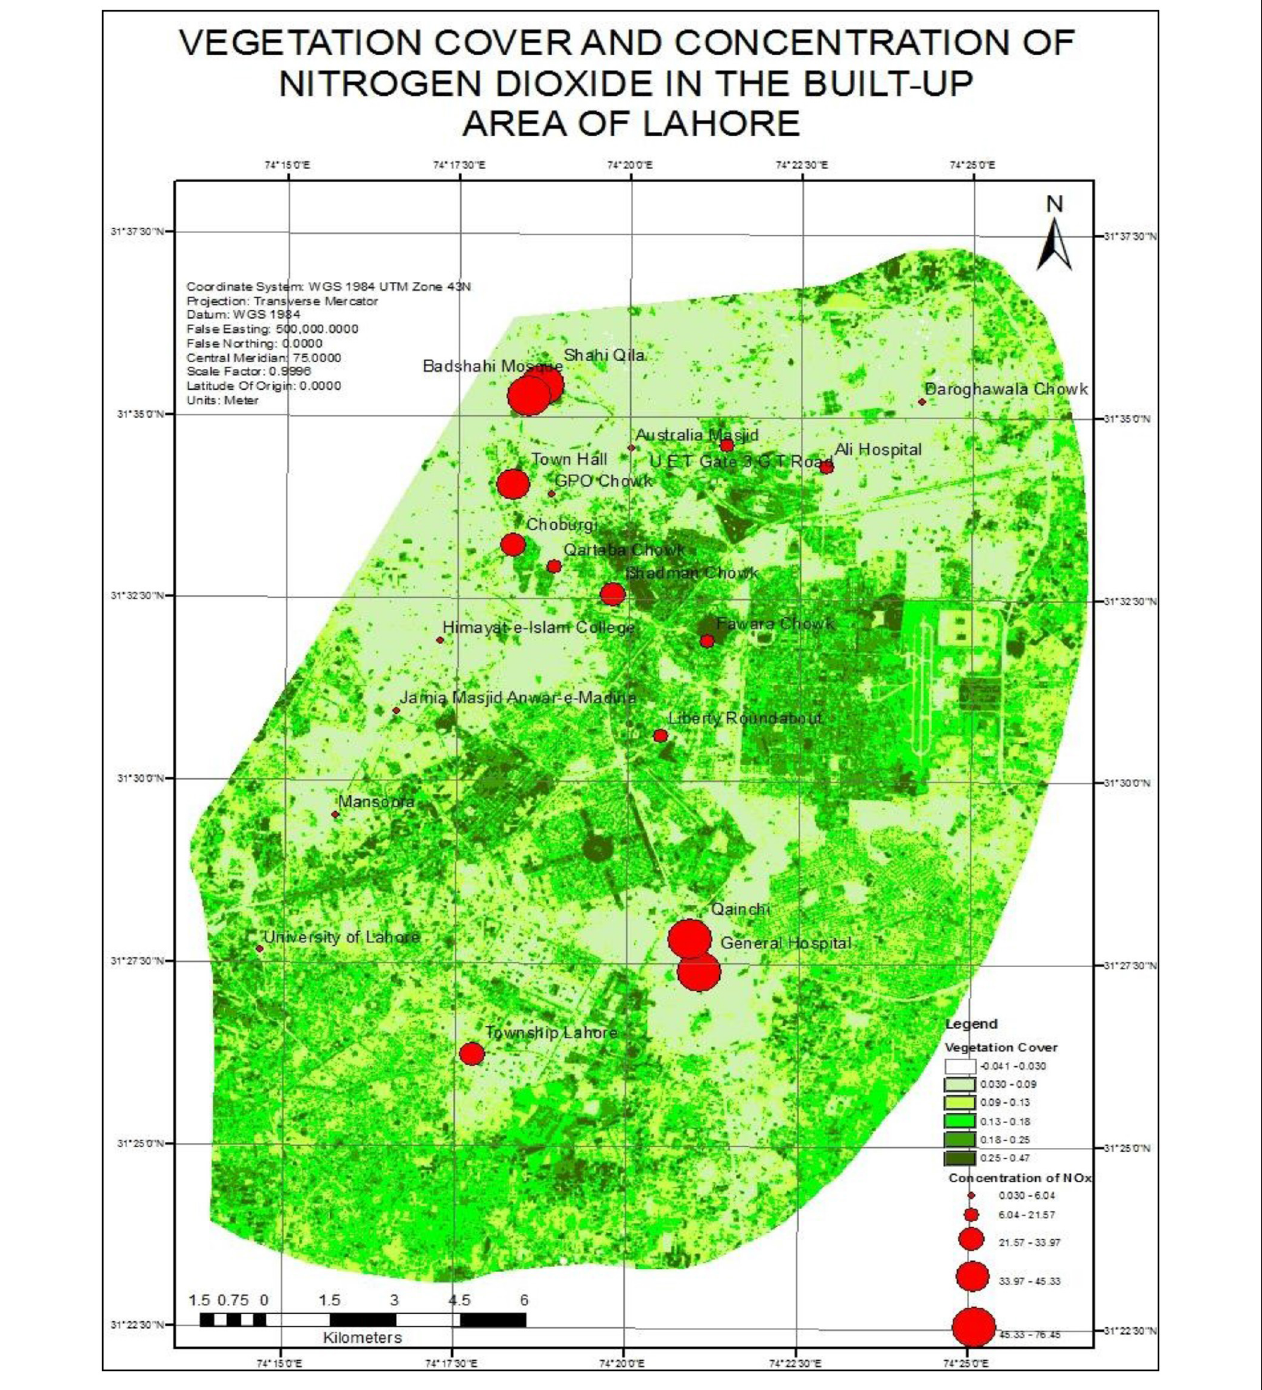
FIGURE 11 | Impact of vegetation on the concentration of nitrogen dioxide.